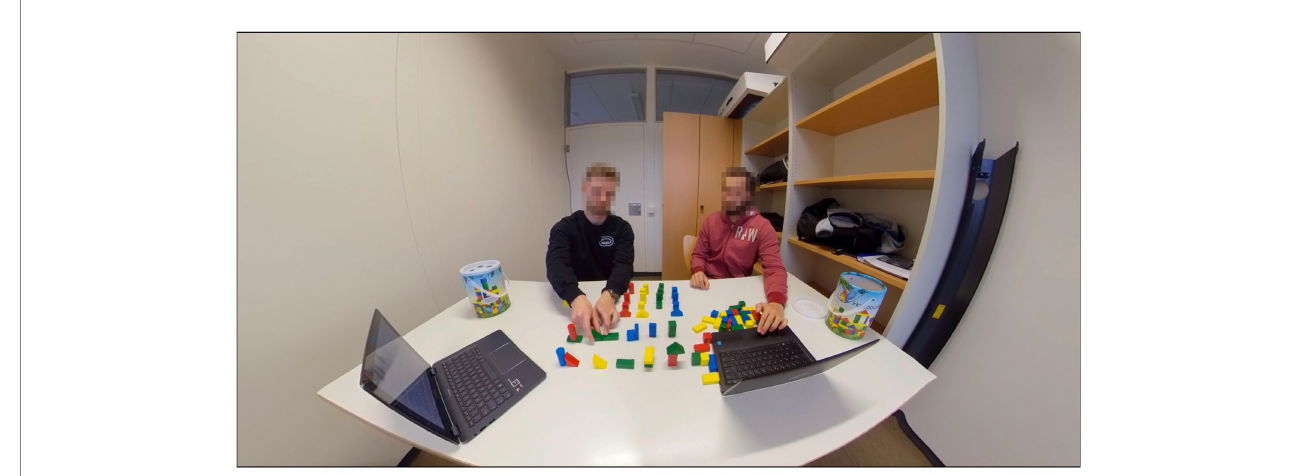
FIGURE 2 Stimulus material: The recorded video material was used for both the 2D and the 3D/360 °